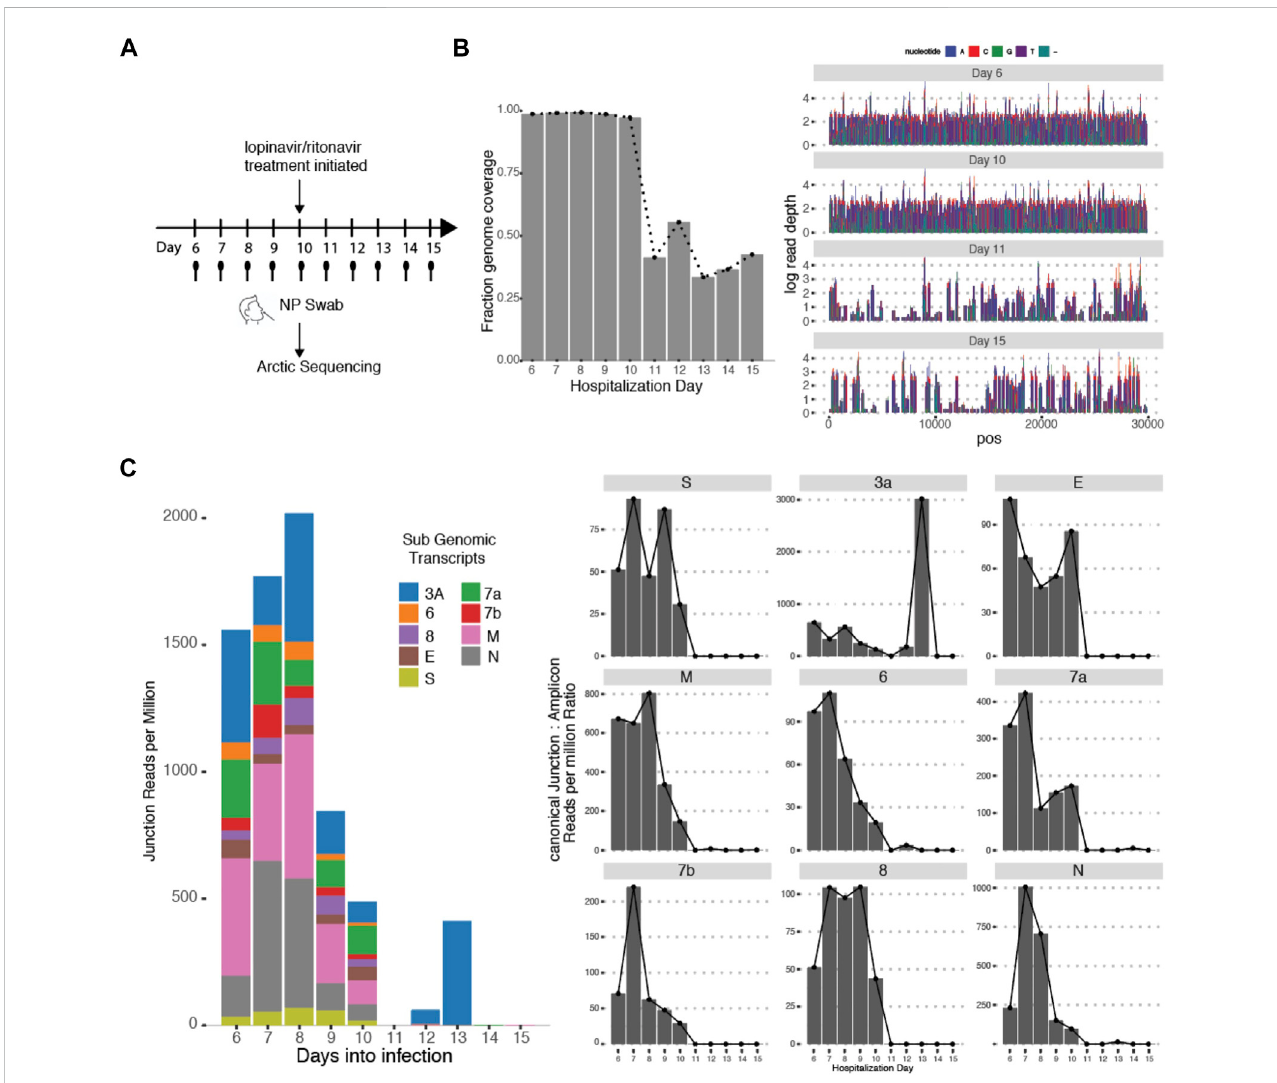
FIGURE 4 Subgenomic JunctionalReadscapturestemporalvariation. (A) SamplingprotocolofPatientP07.Patientwassampleddailyfromday6ofhospitalization. Patient was treated with Lopinavir/ritonavir from day 10 onwards. (B) (left) Genome coverage by Arctic sequencing across the 10 timepoints. (right) Raw read coverage across the genome for Day 6, 10,11,15. Sequencing depth was similar across all timepoints (Supplementary Figure S1) (C) (left) Stacked bar graphs re fl ecting the amount of normalized sub genomic gapped reads for each of the nine canonical subgenomic transcripts across the 10 timepoints. (right) Distribution of normalized individual subgenomic gapped read counts across the 10